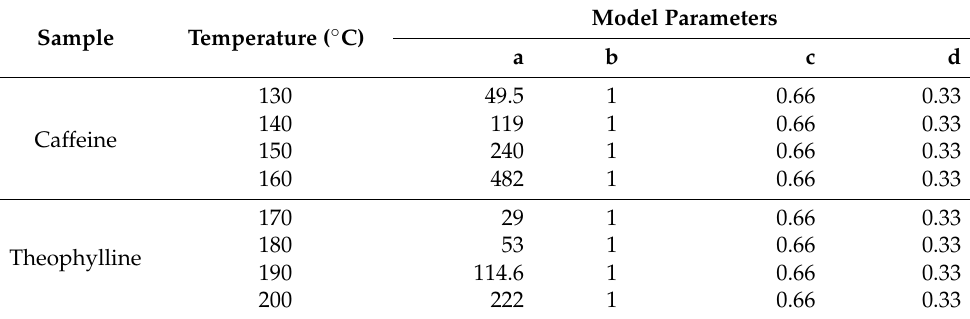
Table 4. The values of coefficients a, b, c, d in the dimensionless Equation